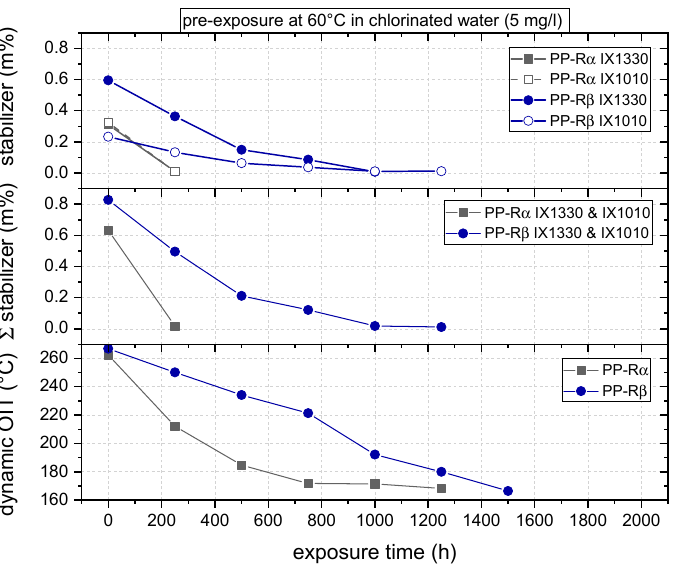
Figure 3. Phenolic antioxidants (IX1010 and IX1330) content and oxidation induction temperature (dynamic OIT) as a function of exposure time for the two polypropylene random copolymers (PP-R) grades.